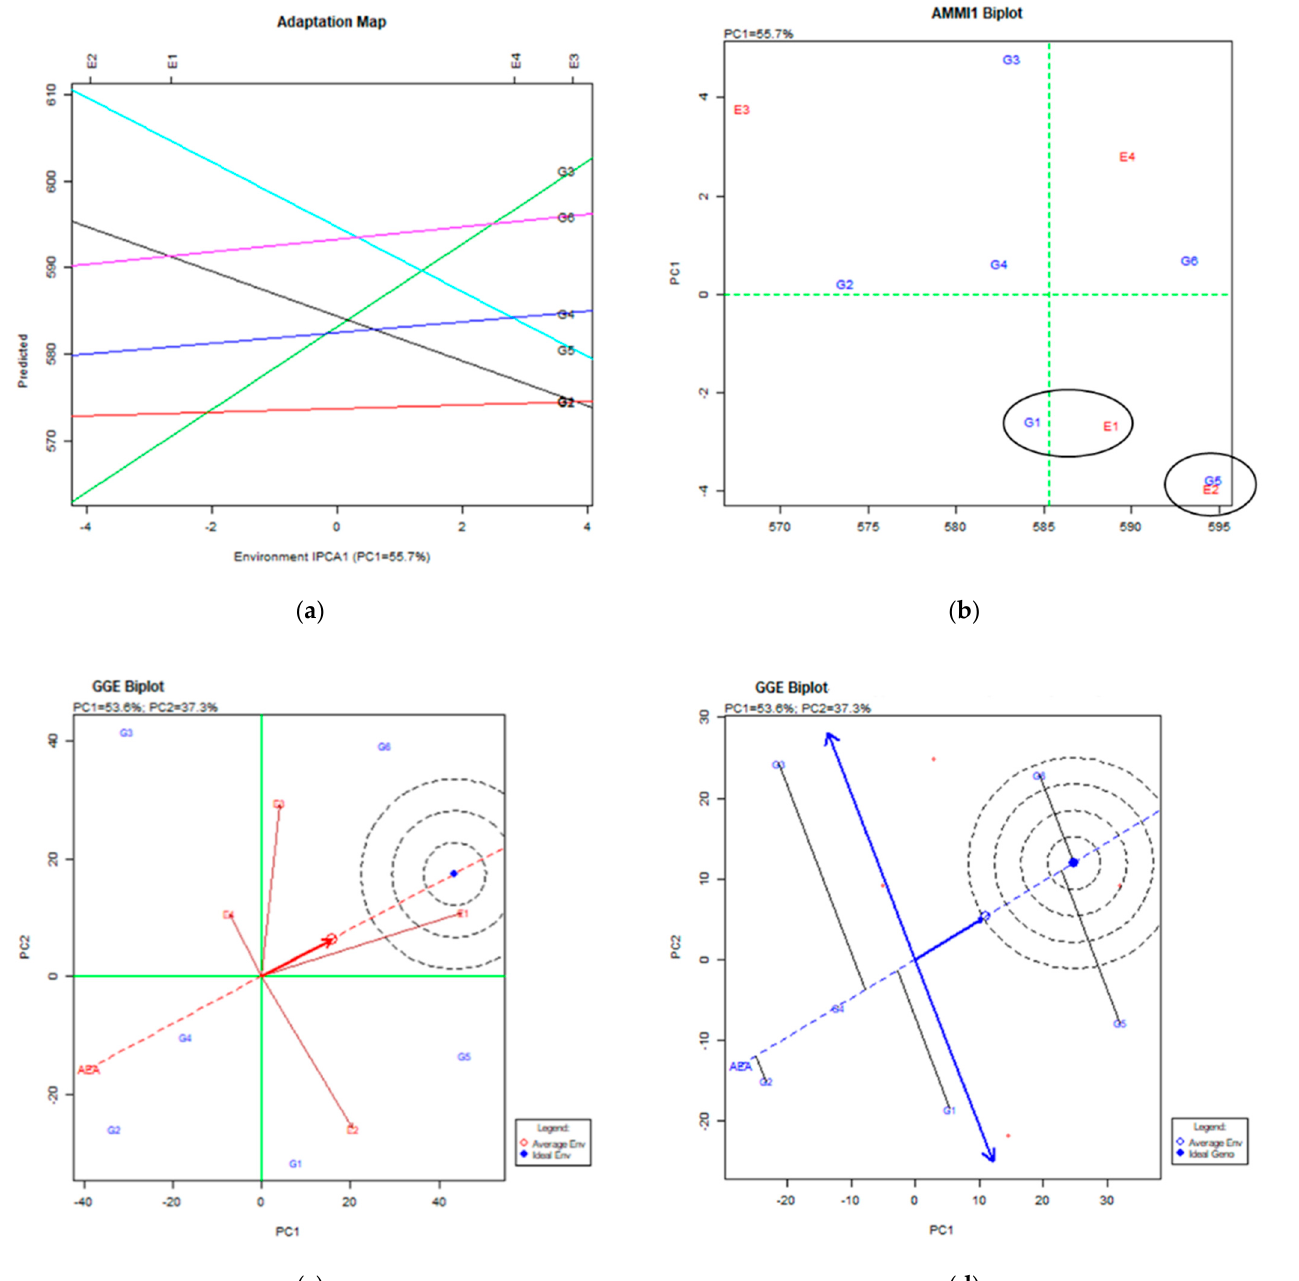
Figure 3. Stability analysis for forage dry matter yield (kg ha − 1 ) based on: ( a ) the adaptation map where the X-axis (PC1) visualizes the stability of varieties over environments and the Y-axis—the performance of varieties for the trait; ( b ) the AMMI1 biplot where the Y-axis is the one visualizing the trait performance and the X-axis (PC1) visualizes the stability of varieties over environments; ( c ) the GGE biplot for environments depicting the stability of the environments over years via the placement as near as possible to the ideal and average environment; ( d ) the GGE biplot for varieties depicting the stability of the varieties over environments where the productive varieties are those to the right on the AEA vector and the stable ones are those which are as close to the AEA axis as possible.